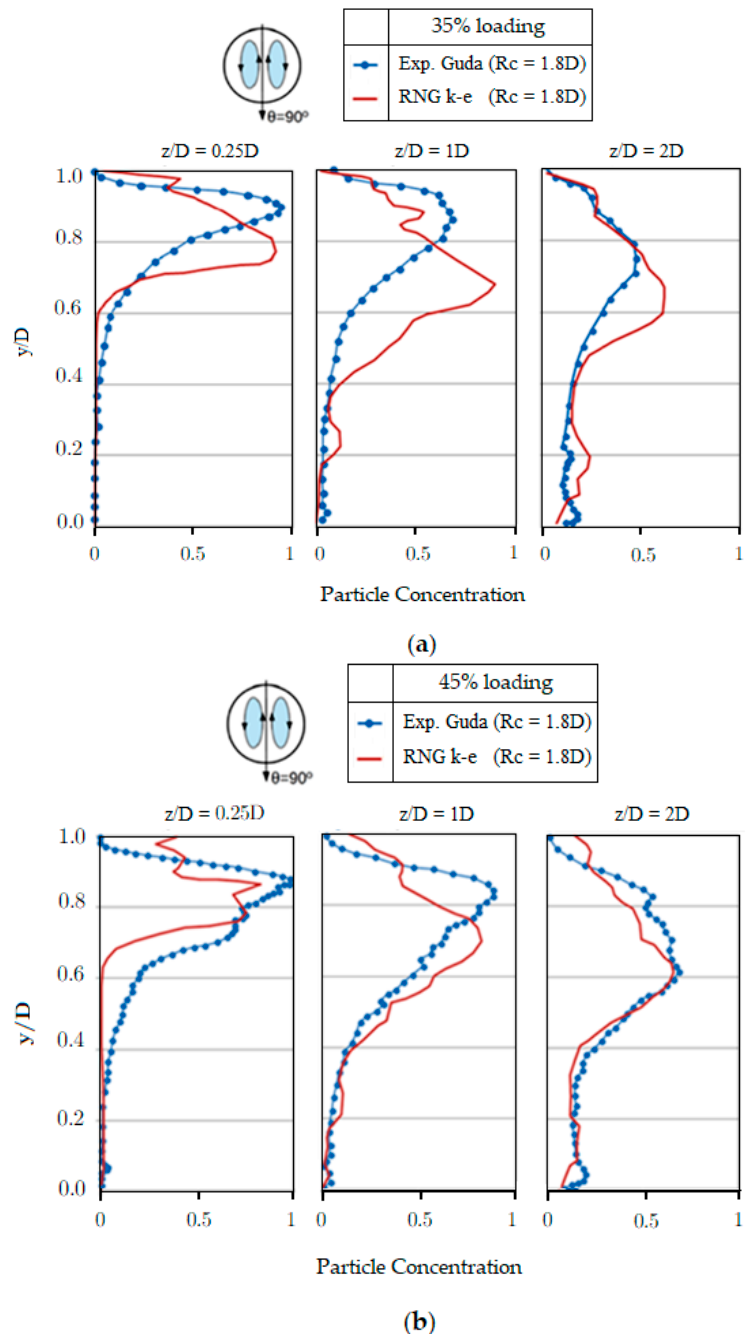
Figure 5. Particle concentration profiles in vertical symmetric lines in “y” ( θ = 90 ◦ ) for z/D = 0.25, z/D =1, z/D =2. Load condition ( a ) 35% and ( b ) 45%. Experimentally computed values ( line marker ) [6] and estimated with RNG k - ε model ( line only ).